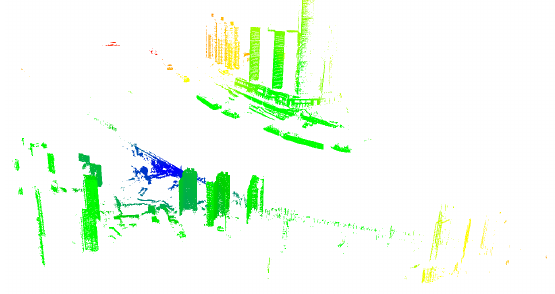
Figure 12. The dataset colored by distance.